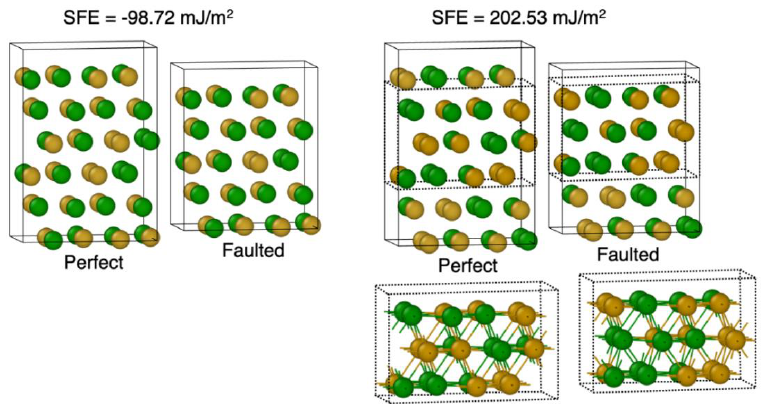
Figure 5. Two different atomic structures used to compute SFE for Ni 50 -Fe 50 alloy. Large SFE variation (−98.72 mJ/m 2 vs 202.53 mJ/m 2 ) is observed. Resulting nearest neighbor environments can be significantly different between perfect and faulted structures when a stacking fault is created. Enlarged insets show such significantly di ff erent nearest neighbor environments between the perfect and faulted structures. (Gold and green colors represent A and B atoms of a binary